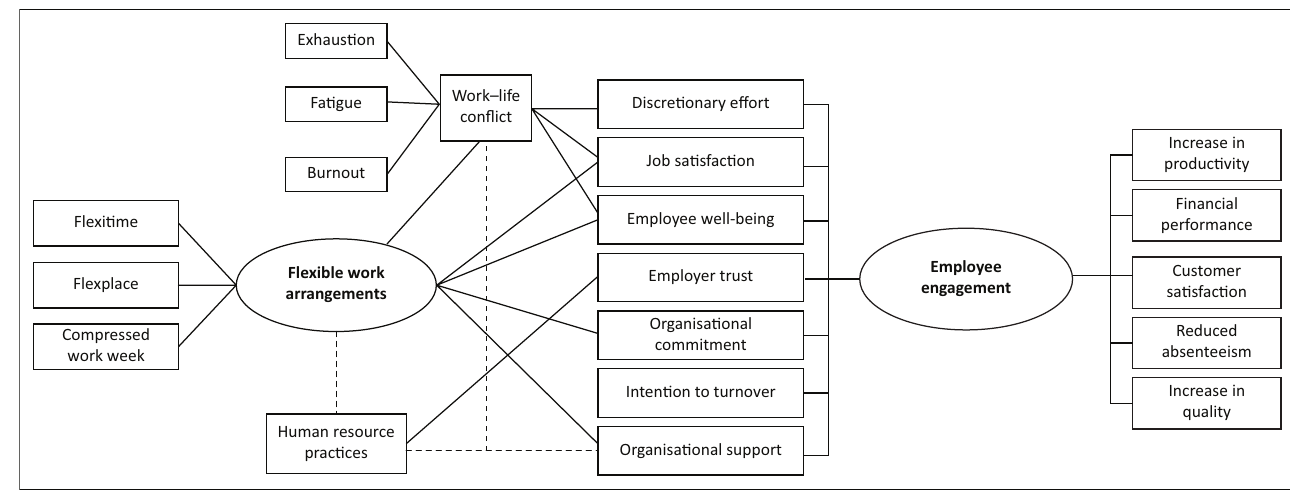
FIG URE 1: Literature review